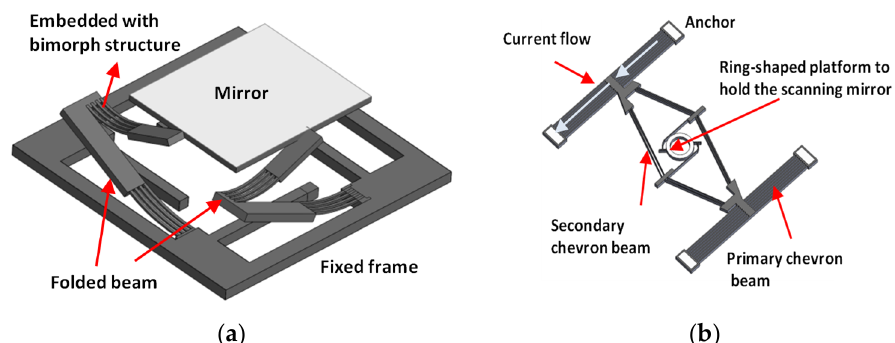
Figure 7. Mechanical structures of ( a ) the 2D scanners with bimorph beam structures to ensure the rotation along the central axes of the mirror [46]; ( b ) the circumferential scanner actuated by cascaded chevron beam to rotate the center ring-shaped platform for the scanning mirror [48].